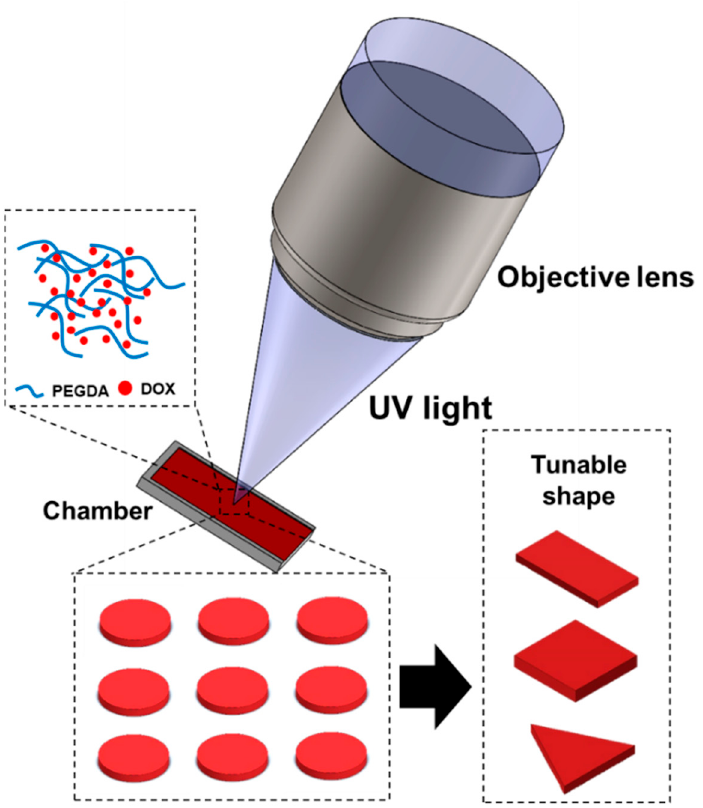
Figure 1. Schematic illustration of the proposed study: UV light is used to pattern the polymer.